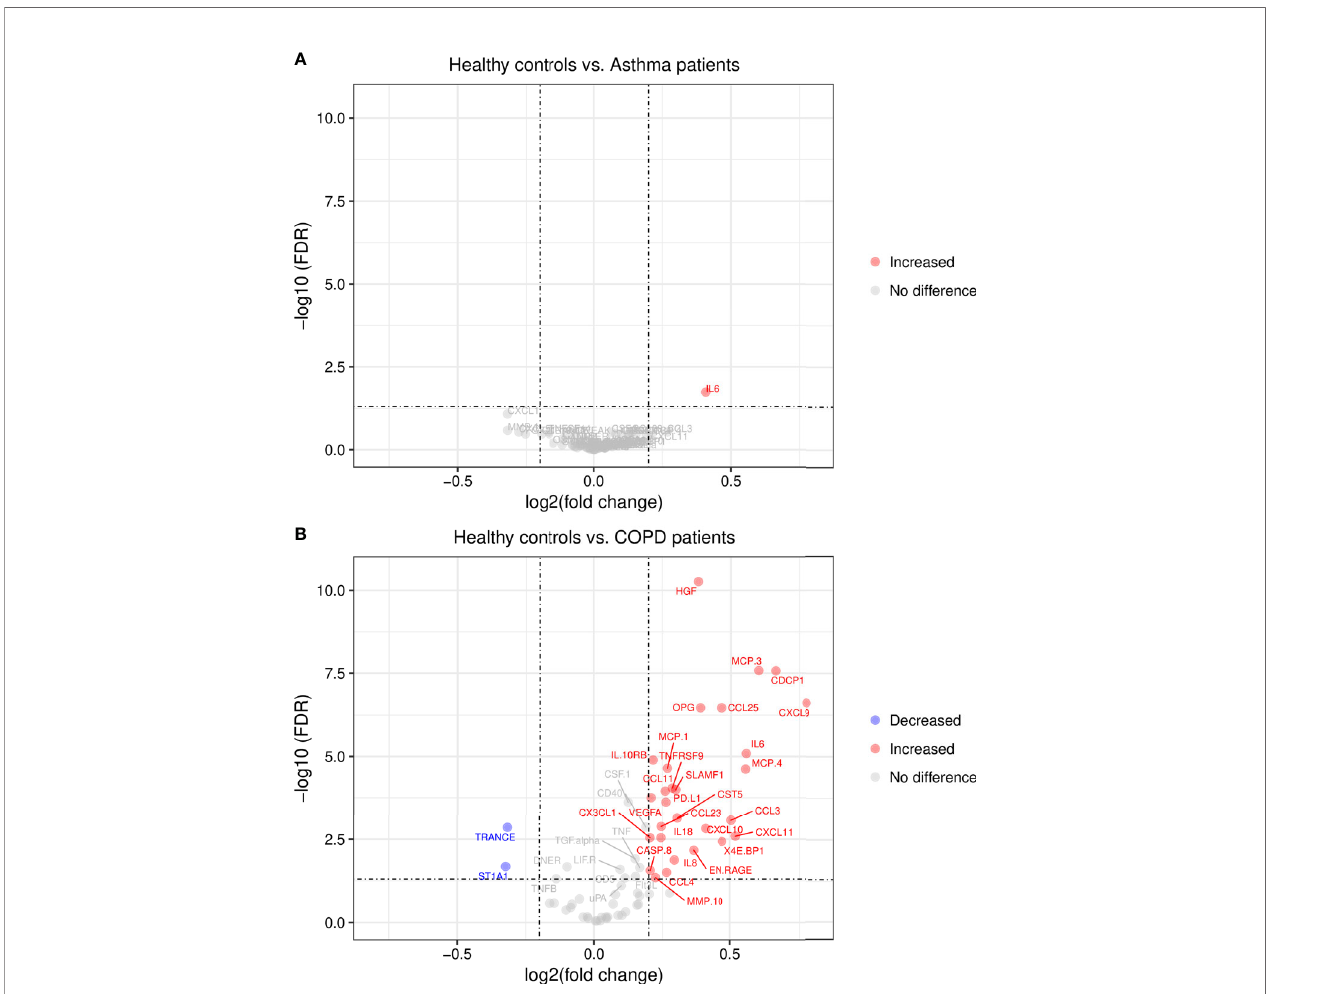
FIGURE 2 | Volcano plots of differentially expressed plasma proteins. (A) in asthma patients and (B) in COPD patients. Lines indicate cut-off points for FDR < 0.05 and log 2 fold change ≥ 0.2; FDR, False Discovery